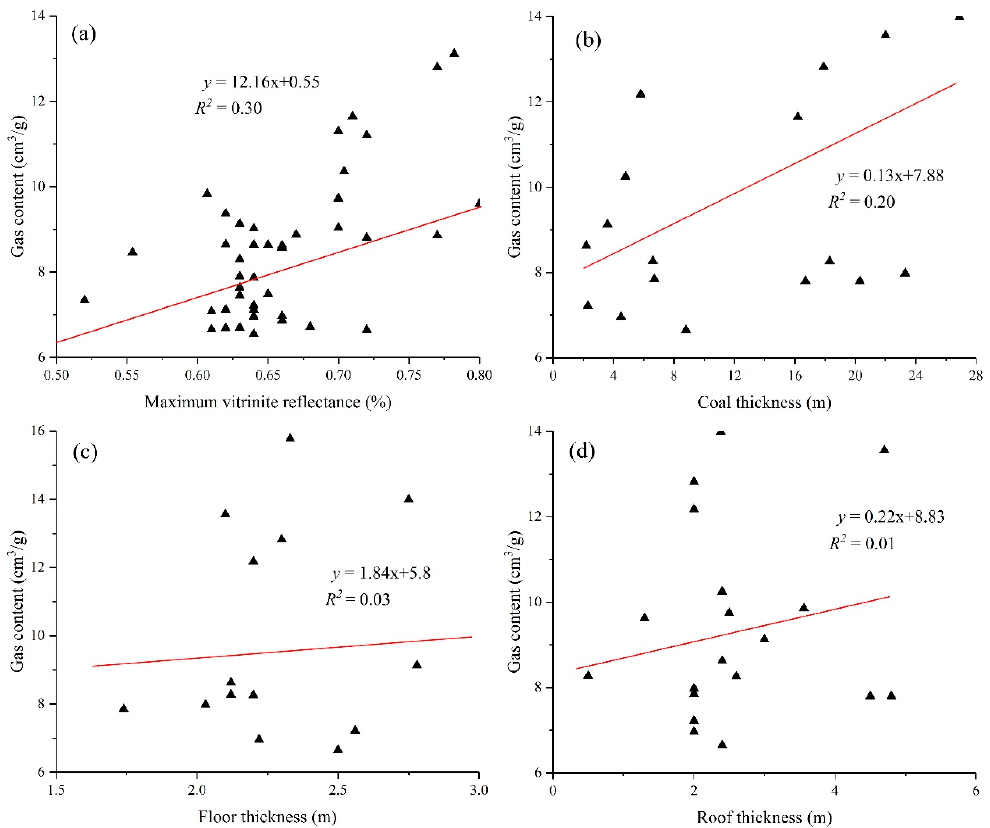
Figure 13. Scatter plots of gas content versus the maximum vitrinite reflectance ( a ), coal thickness ( b ), floor thickness ( c ), and roof thickness ( d ) in the Fukang syncline and Ergonghe syncline, SJB.